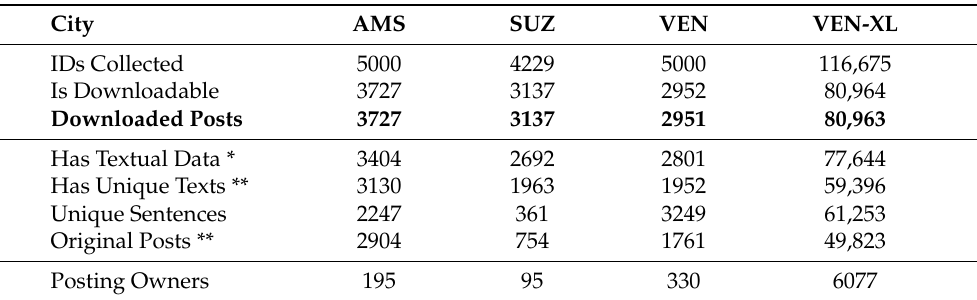
Table 2. The number of data samples collected at each stage, the bold numbers mark the sample size of the final